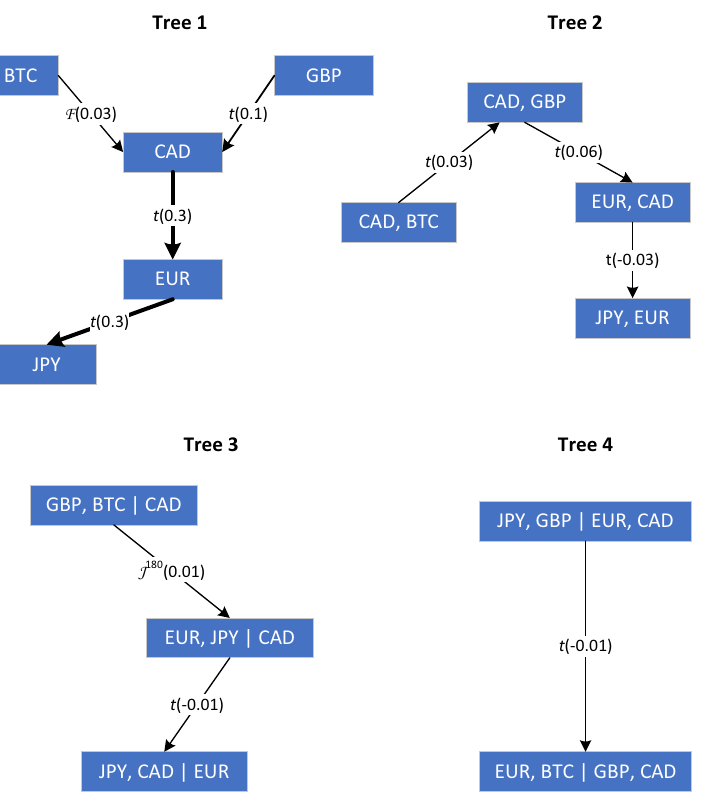
Fig. 4 Estimated R-vine decomposition for G7 basket. The direction of the dependence transmission path is characterized by an arrow that indicates the pair copula and Kendall’s τ in parentheses. The strength of the dependence is illustrated with the thickness of the